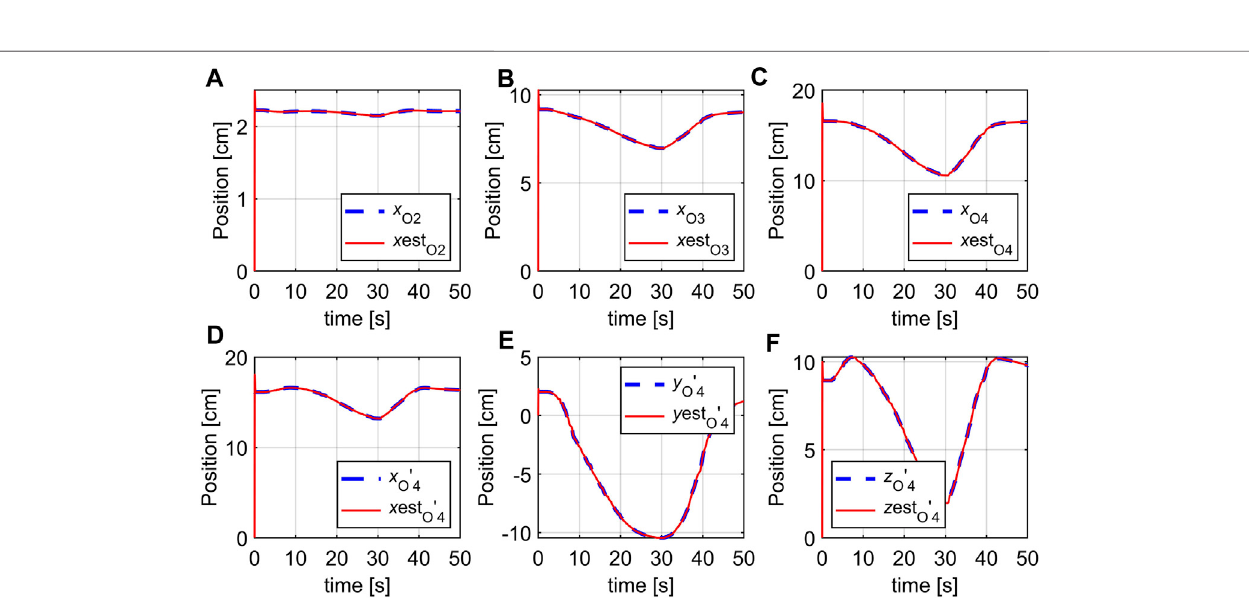
at − 0.2 rad, the estimated variables returned by the observer quickly converge to the true states (from the simulation of the plant), in every subsystem. Figure 11 . It can be observed that the estimates of the rates of changes of the space variables can quickly converge to the true values from their initial values at 5, and without steady-state errors. There are de fi nitely some biases when switching between the subsystems but the steady estimates will be obtained within a short time after entering a new subsystem. Note that the convergence can be smoother at switching points if we